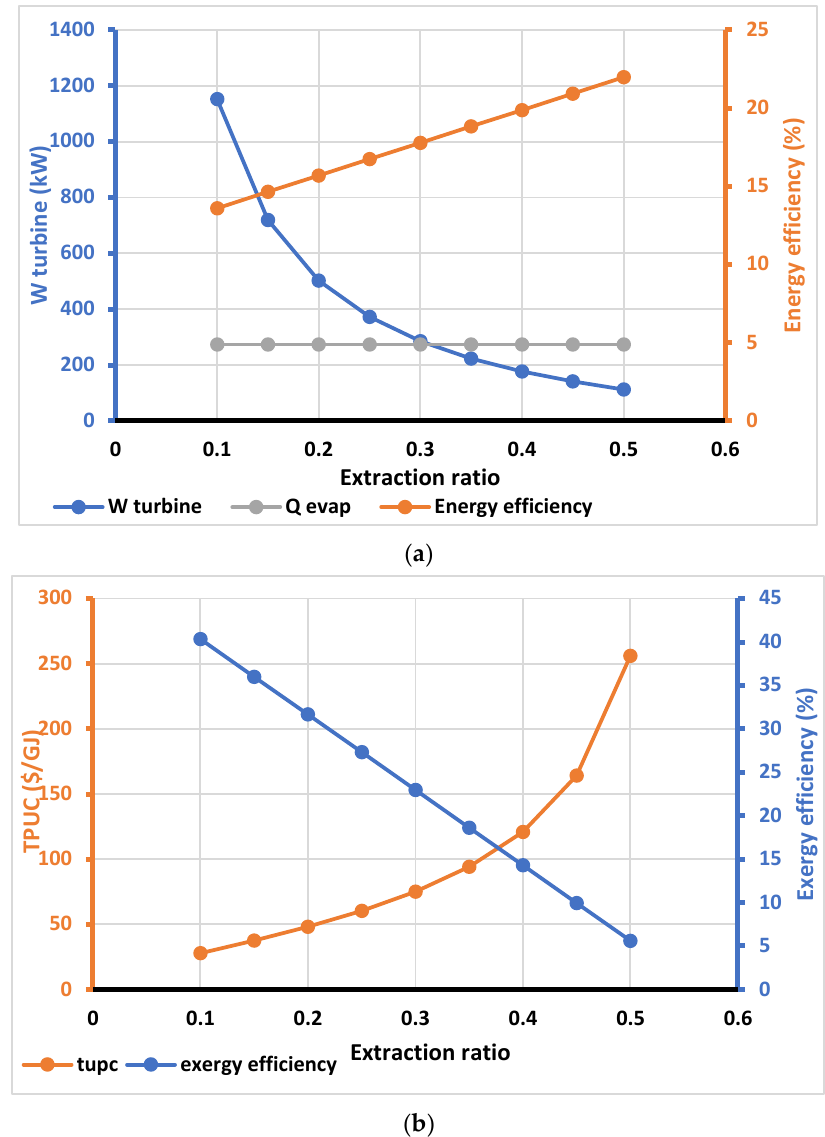
Figure 14. ( a ) Effect of the extraction ratio on energy efficiency, cooling, and power generation. ( b ) Effect of the extraction ratio on exergy efficiency and TPUC.